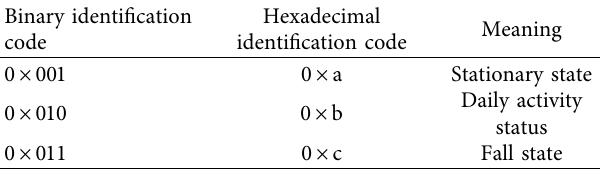
Table 1: Human motion status identifiers.